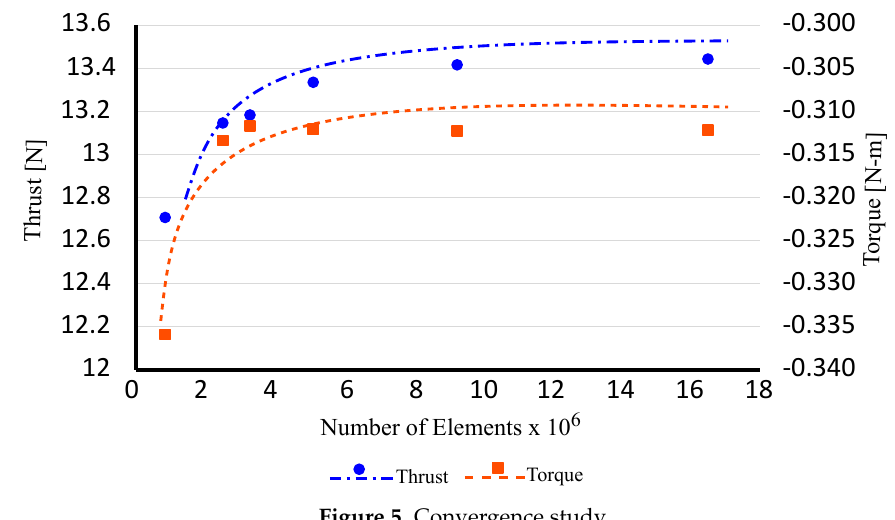
Figure 5. Convergence study. Table 1. Mesh characteristics for the convergence